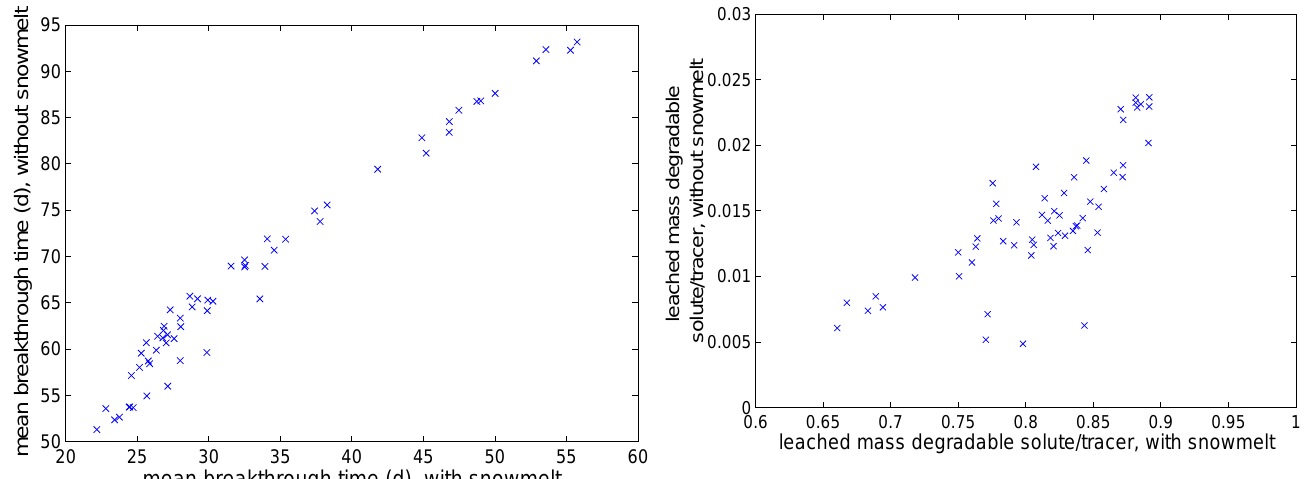
Fig. 15. Leached mass of degradable solute (half-life time τ = 10d) divided by the leached mass of the tracer per cell, for the year 1997 with and without snowmelt, at 0.5 m depth.